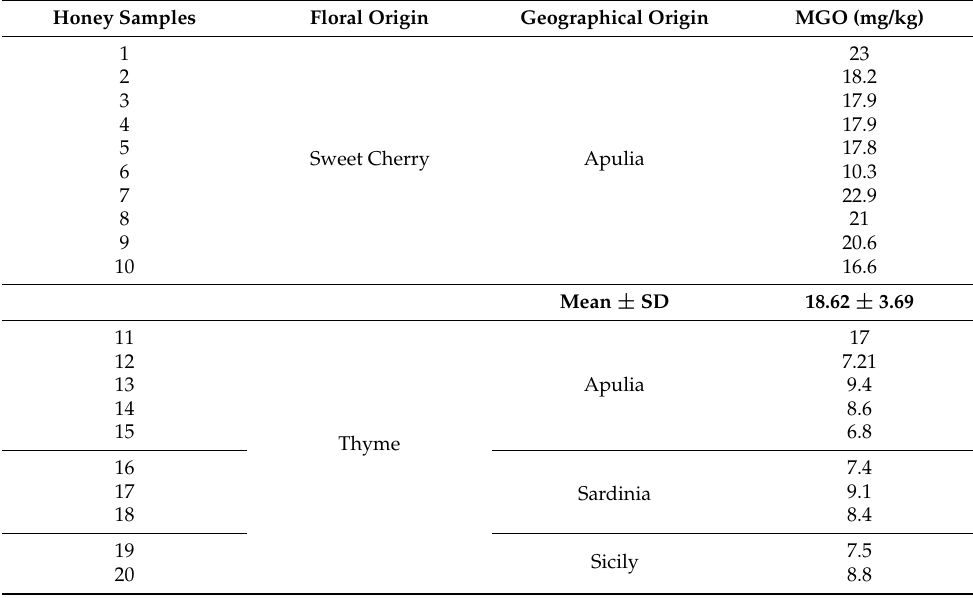
Table 3. Levels of methylglyoxal (MGO) in Italian honey samples. Honey